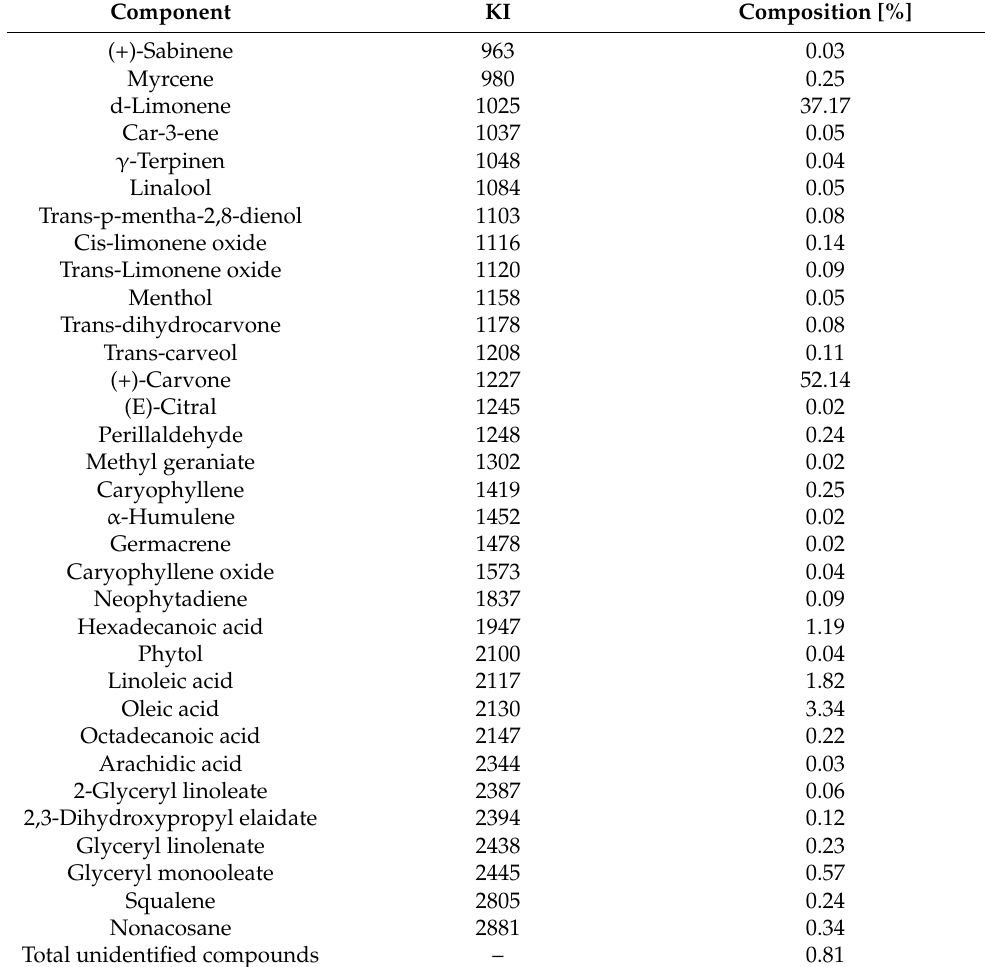
Table 5. Volatile compounds of Carum carvi L. subcritical carbon dioxide